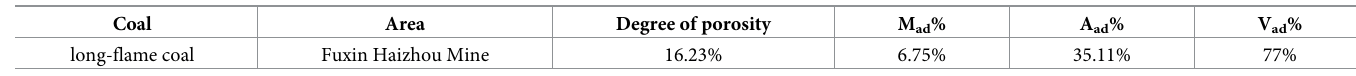
Table 1. Industrial parameters of the coal sample.